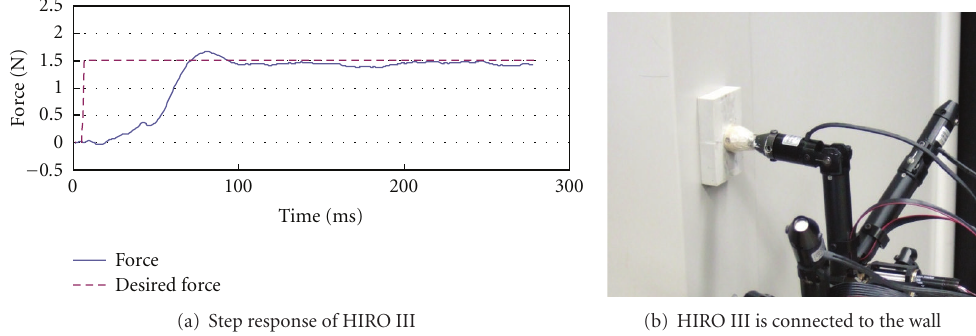
Figure 7: Performance of HIRO III (Step